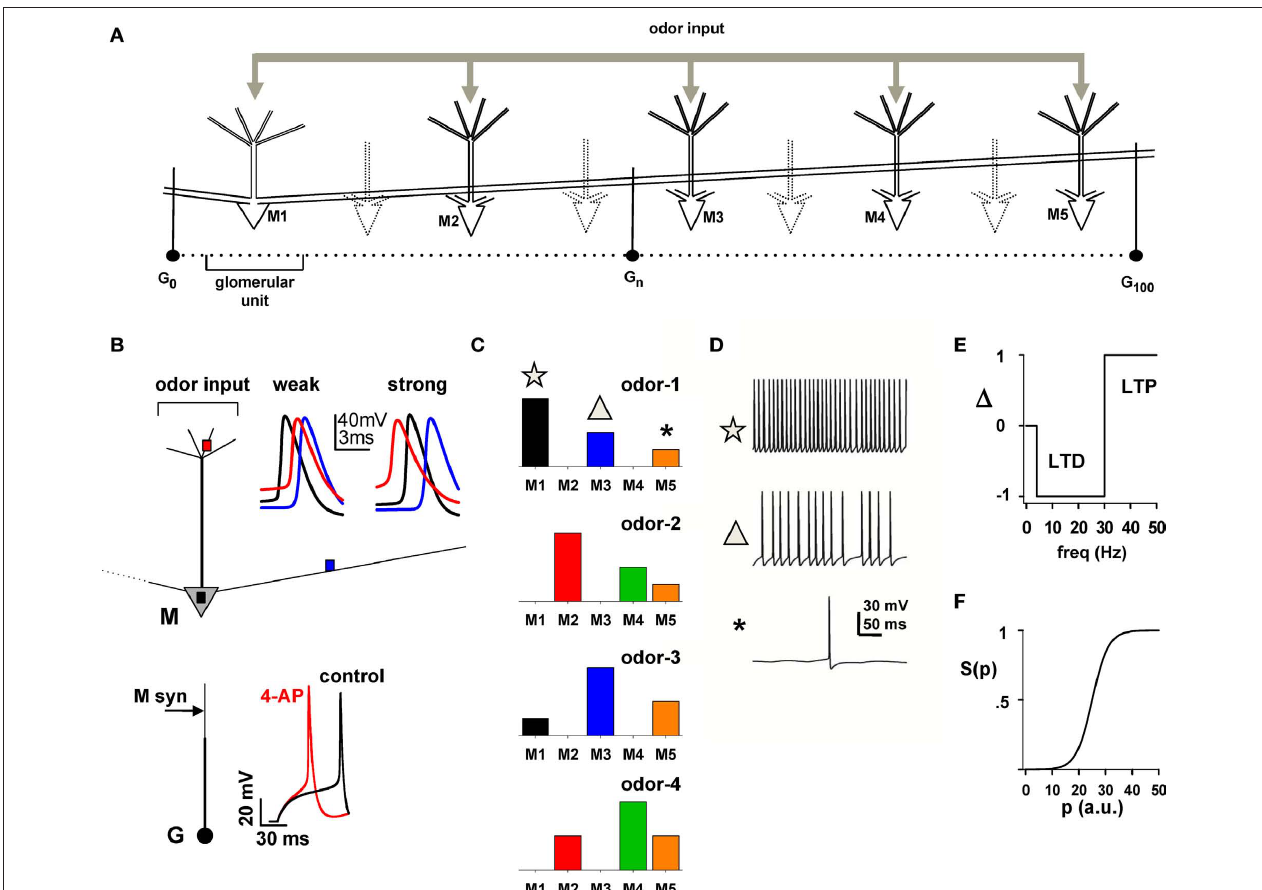
FIgure 1 | Layout of the basic model for simulating the response of the dendrite indicates the location of mitral cell synaptic input. (C) The five mitral network to a battery of odors. (A) Schematic arrangement of dendrodendritic cells in (A) were stimulated by four odors with different relative strengths, synapses between mitral and granule cells; only mitral cells M1–M5 were indicated by the bars. (D) Simultaneous recordings of somatic traces for M1, explicitly modeled; “glomerular unit” indicates a mitral cell and its closest M3, and M5 during a typical activation of odor 1; symbols correlate mitral cell related granule cells. (B) Mitral (M) and Granule (G) cell properties; top : the firing with the strength of input in (C) . (e,F) Rule for long-term potentiation traces show the membrane potential at different mitral cell locations (colored (LTP) and long-term depression (LTD) of mitral–granule cell reciprocal synapses squares) during a single odor input activation (for clarity, only the first AP is (from Migliore et al., 2007); the instantaneous frequency of each interspike shown); bottom : Traces show the granule cell somatic membrane potential interval at each synaptic location determines the value of ∆ ; this is used to during a somatic current injection (25 pA) under control and after simulated update the value of p and, consequently, the peak synaptic conductance as application of 4-aminopyridine, which blocks A-type K + channels (4-AP, modeled w = g . S ( p + ∆ ); the function S ( p ) determines the current state of {exc,inh}, p +∆ syn,{exc,inh} with a 80% reduction of the K conductance). The arrow on the granule cell a synaptic A